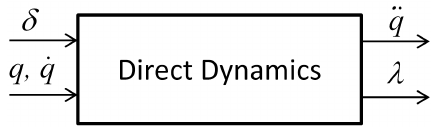
Figure 1. Direct Dynamic Model: main input /